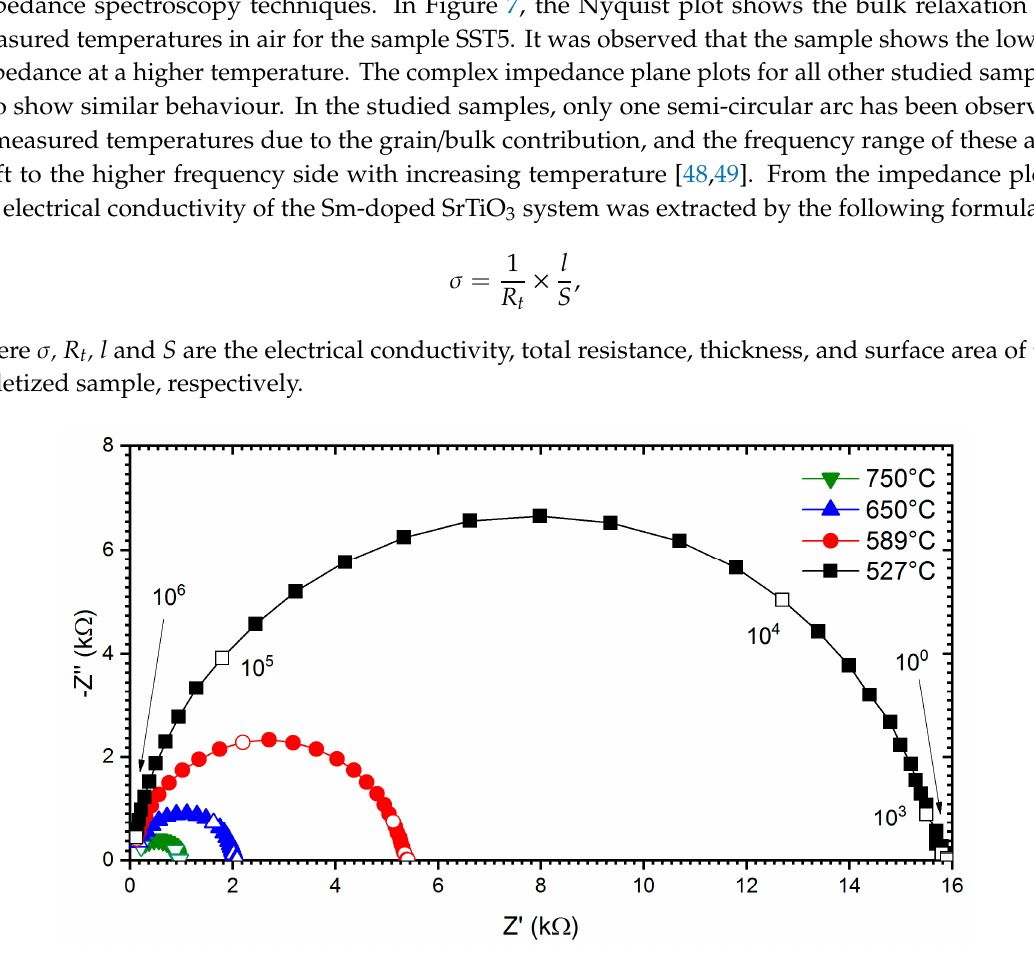
Figure 6. ( a ) The typical electrical conductivity spectra of SST5 composition fitted with Jonscher’s power law and ( b ) scaling of conductivity spectra at measured temperatures for the composition SST5.